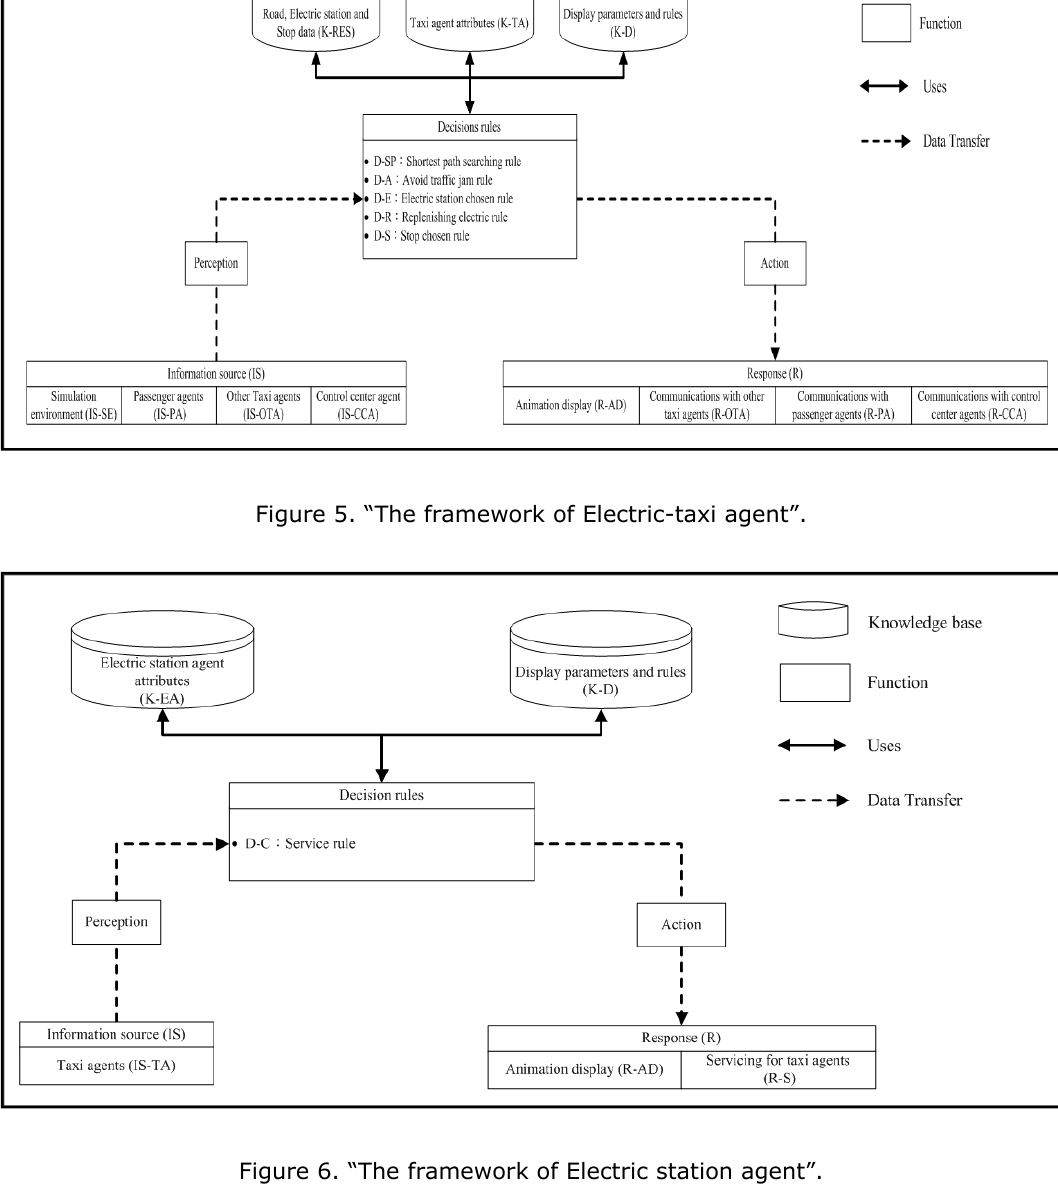
Figure 6. “The framework of Electric station